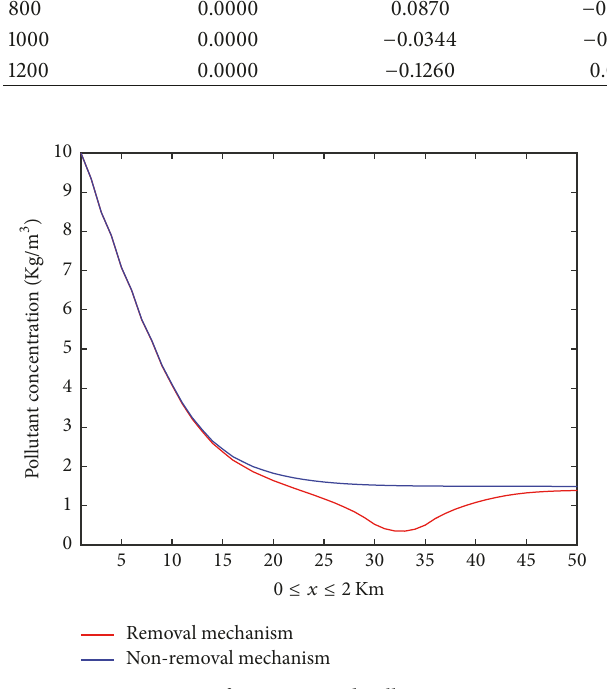
Figure 6: Comparison of approximated pollutant concentrations in removal mechanism system and nonremoval mechanism system.